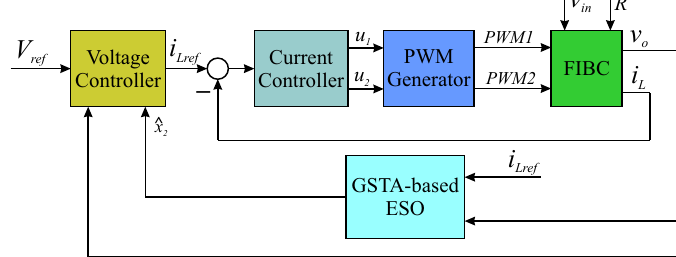
Figure 2. The suggested control scheme for the